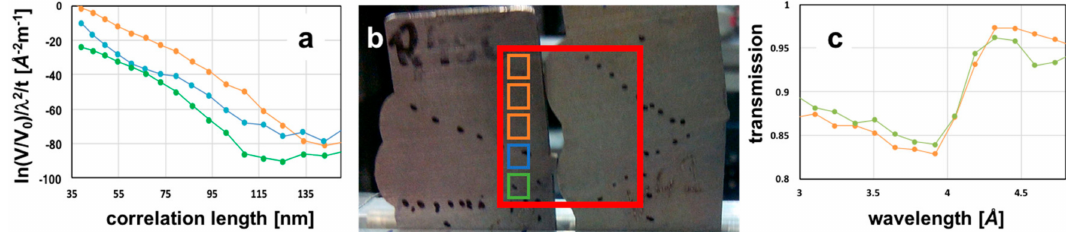
Figure 6. Time-of-flight dark-field imaging of steel welds: ( a ) real space correlation functions of three distinct areas of a 1.5 mm thick steel weld; ( b ) photograph of the sample(s) with the color coded regions of interest analysed in ( a ) and ( c ); ( c ) simultaneously recorded wavelength dependent transmission data of two color coded regions of interest ( b ) in the weld, displaying the Bragg edge pattern around the Fe(110) Bragg